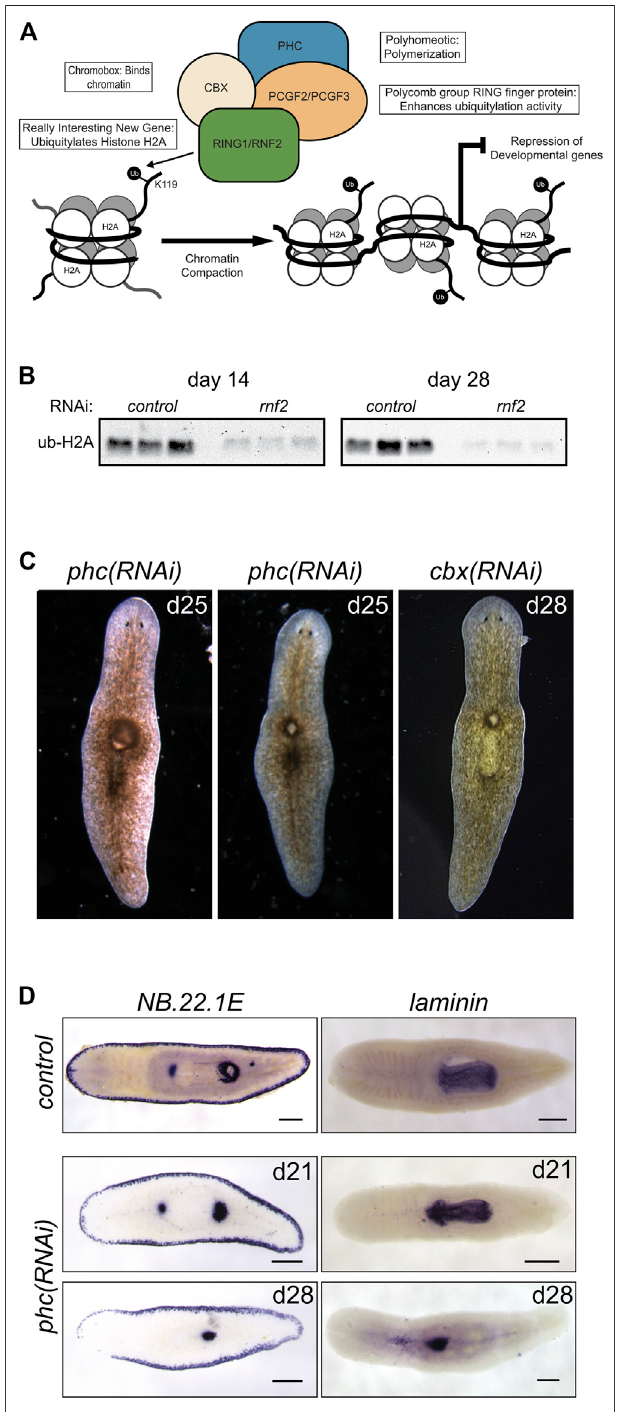
FIGURE 6 | RNAi-mediated inhibition of canonical PRC1 function disrupts pharyngeal patterning and histone ubiquitylation. (A) Composition and function of PRC1. PRC1 functions to ubiquitylate histone H2A and compact chromatin to repress gene expression. (B) Western blot analysis showed a reduction in H2Aub1 levels following rnf2 inhibition across threebiologicalreplicatesandtwoexperimentaltimepoints. (C) RNAiofPRC1 genes phc and cbx causes phenotypes of a dorsal lesion anterior to the ( Continued )